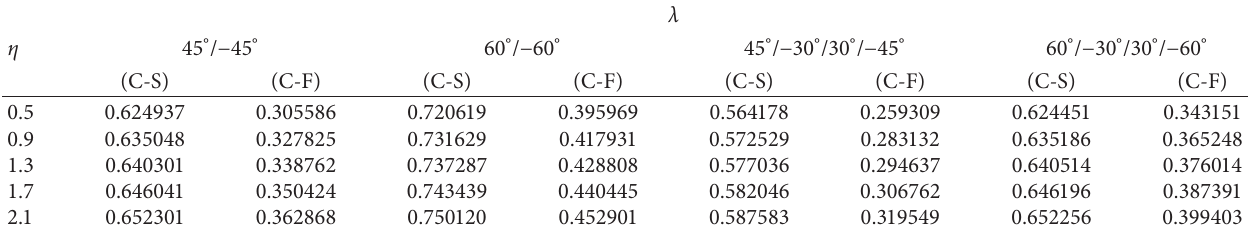
Table 4: Fundamental frequency parameter value with taper ratio for different support conditions.